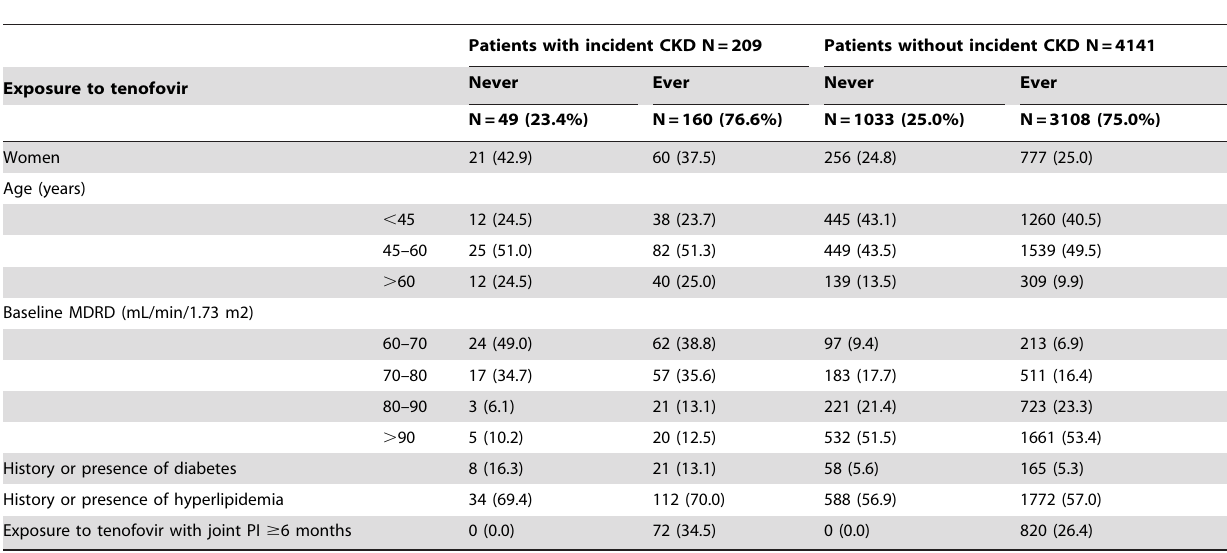
Table 3. Distribution of risk factors at the end of follow-up among 209 patients with incident CKD and 4141 without CKD stratified by exposure to tenofovir, ANRS CO3 Aquitaine Cohort